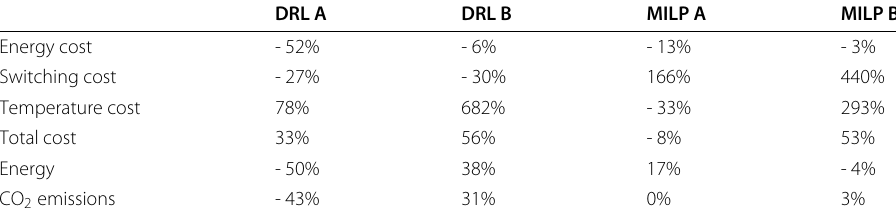
Table 4 Results of the DRL and MILP controller compared to the conventional controller DRL A DRL B MILP A MILP B Energy cost - 52% - 6% - 13% - 3% Switching cost - 27% - 30% 166% 440% Temperature cost 78% 682% - 33% 293% Total cost 33% 56% Energy - 50% 38% 17% - 4% CO 2 emissions - 43% 31% 0%